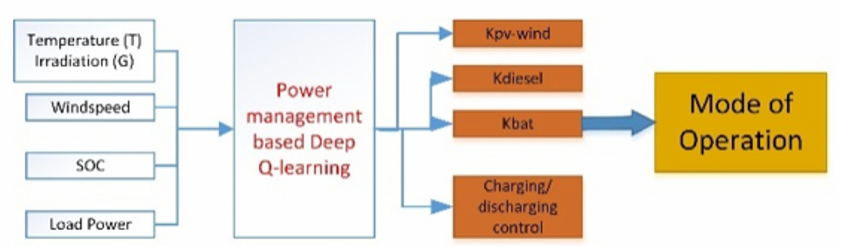
Figure 3. The proposed HRES.